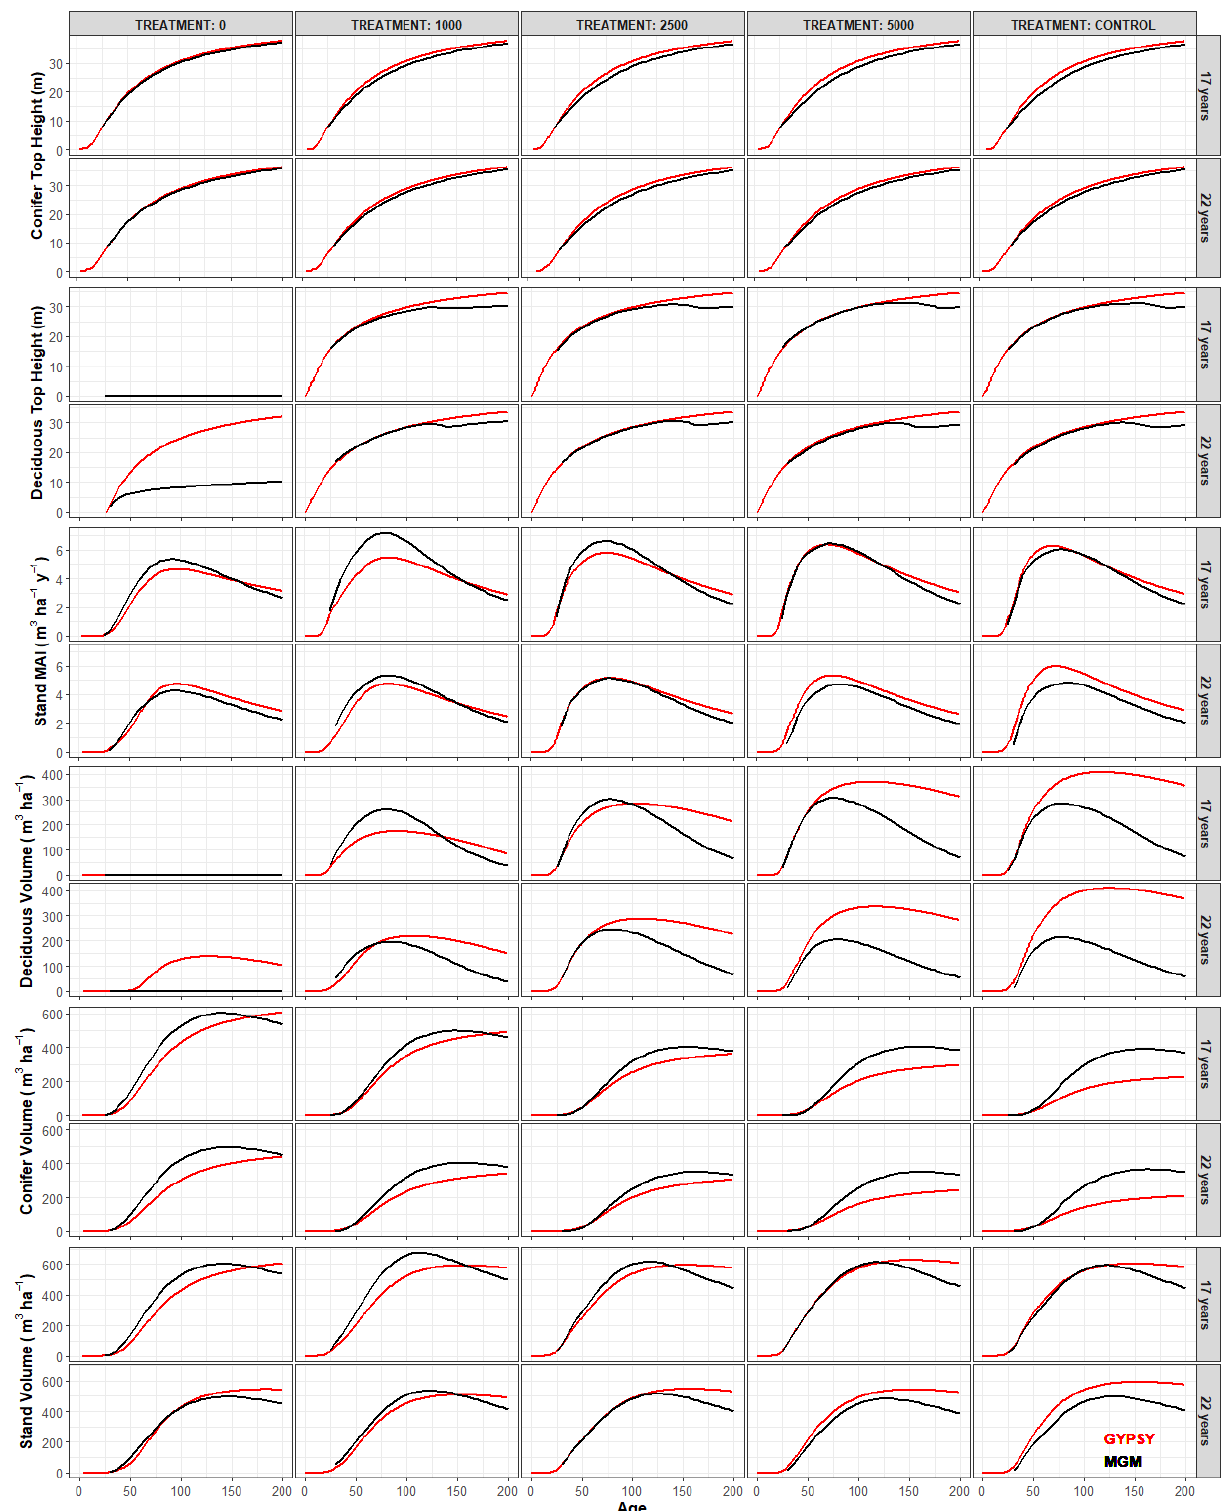
Figure 5. Predicted growth trajectories from MGM and GYPSY. Top heights show predictions with no utilization standards applied, MAI and volume predictions are with “15/10” utilization standards applied. Treatments consider aspen thinned to the following densities: 0 stems ha − 1 , 1000 stems ha − 1 , 2500 stems ha − 1 , 5000 stems ha − 1 , and unthinned (control).